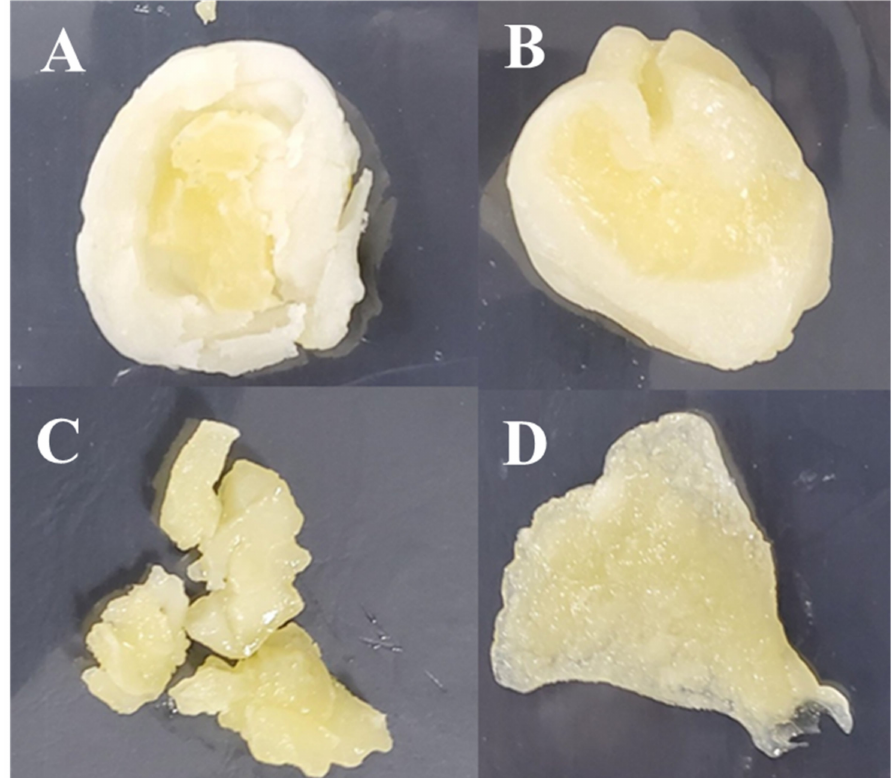
Figure 5. Meltability test of sliced LC-CD and LM-CD samples at storage times of 30 days: ( A ) Sliced LC-CD samples ( B ) sliced LM-CD samples ( C ), Cheese in which Lactobacillus curvatus was dominant ( D ) Cheese in which Leuconostoc mesenteroides was